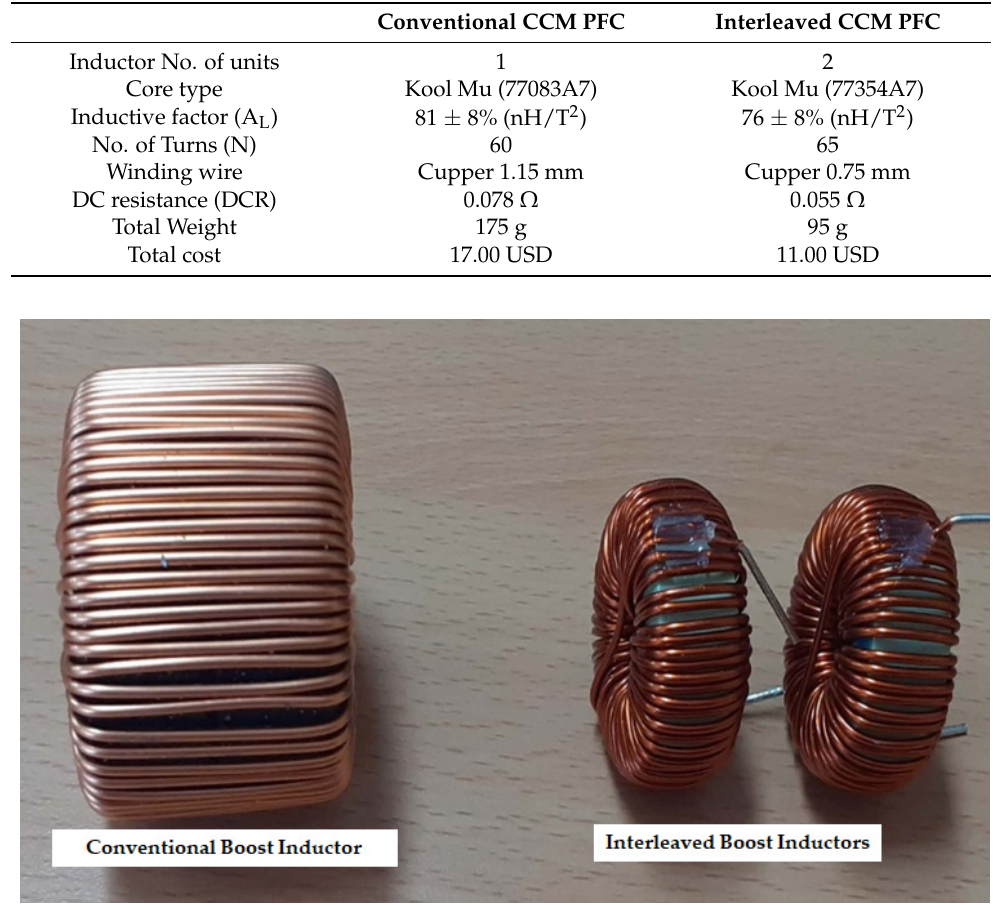
Figure 7. The manufactured PFC boost